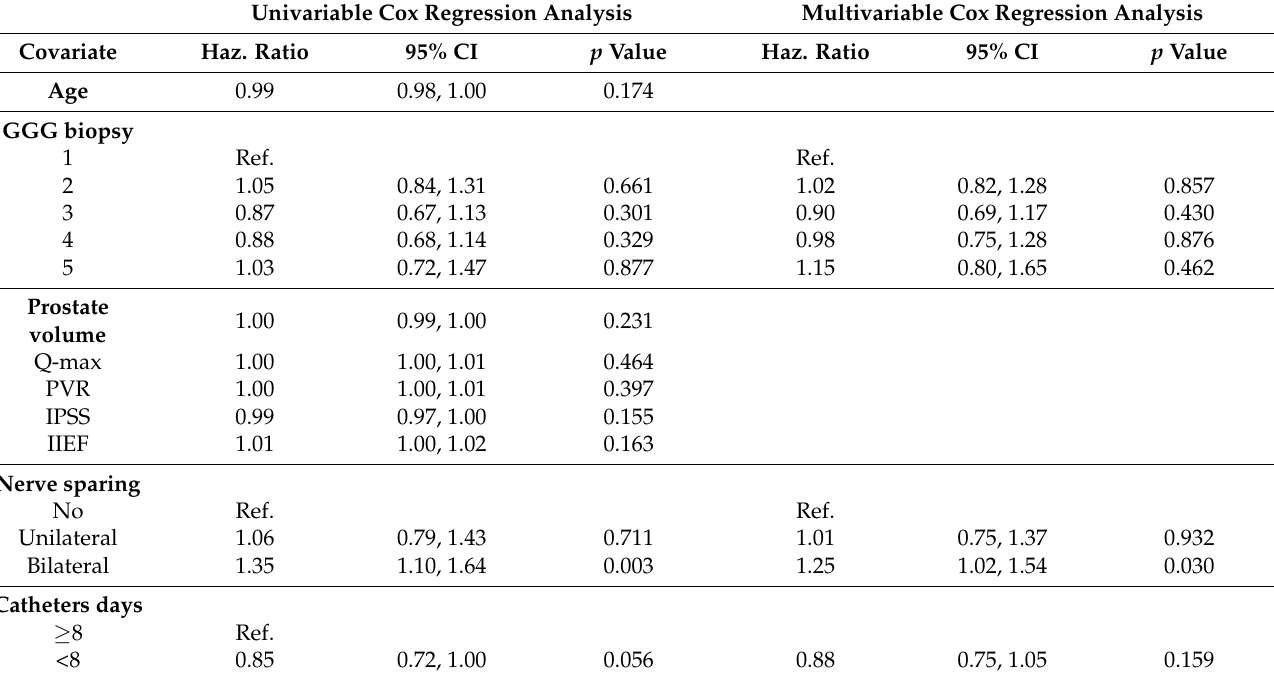
Table 4. Univariable and multivariable Cox Regression Analysis to predict continence recovery in the entire